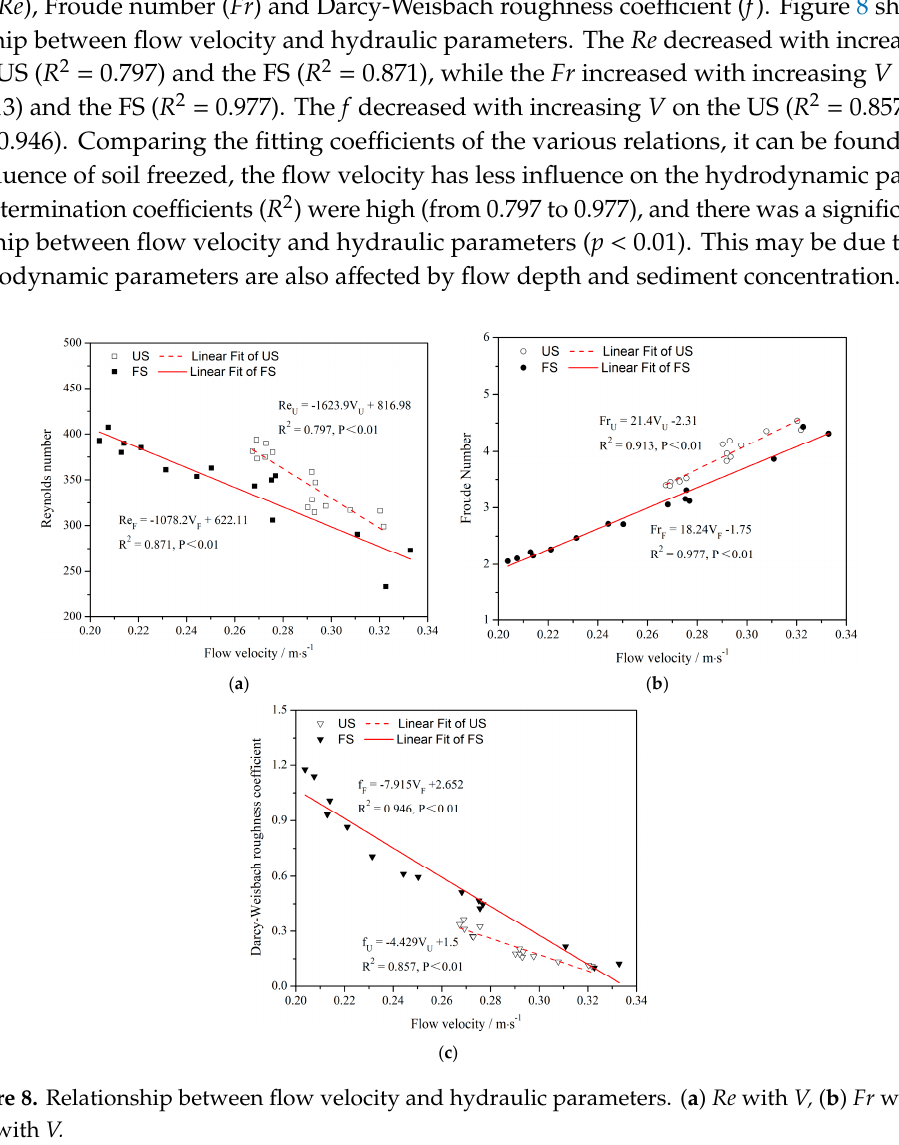
Table 7. Variations of Darcy-Weisbach roughness coe ffi cient with the distance from the top of the slope. Distance from the Top of the Slope E / m Treatment 0.5